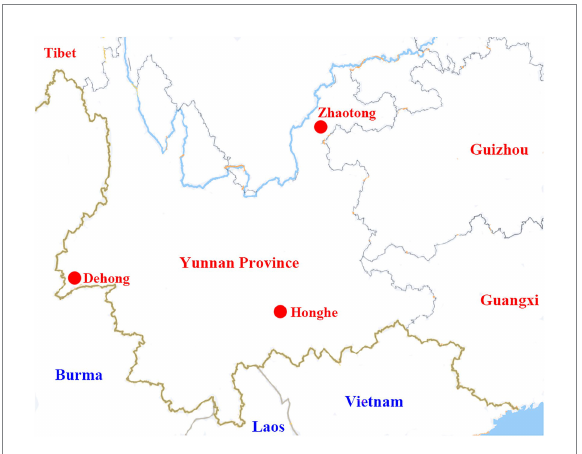
FIGURE 1 A map showing the locations of Dehong, Honghe, and Zhaotong in Yunnan Province, where the tick samples were